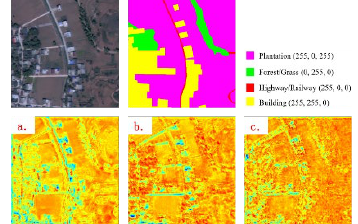
Figure 10. Visualization of the attentions generated from feature maps a , b , c (the same as in Tab. 1) in the bottom.